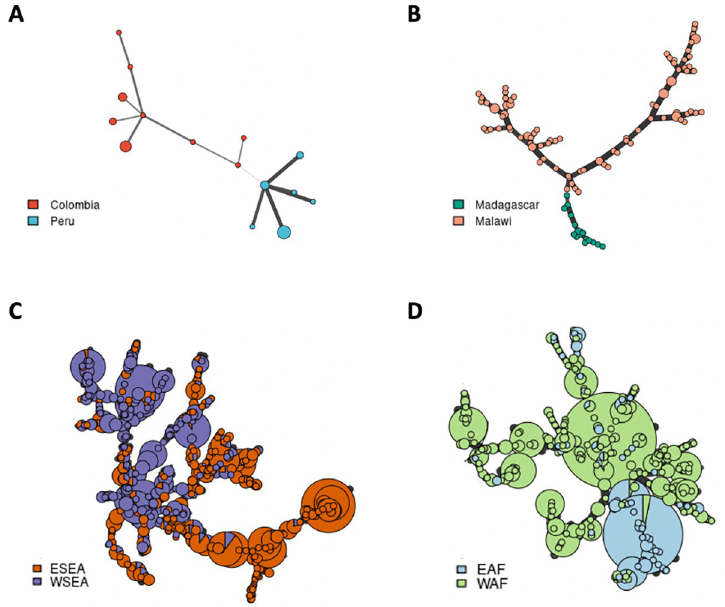
Fig 6. Minimum spanning network among two groups of P . falciparum isolates. Minimum spanning network using Bruvo’s distances based on the ten most informative STR markers. (A) Colombia and Peru from the SAM population. (B) Madagascar and Malawi from the EAF population. (C) ESEA and WSEA populations. (D) EAF and WAF populations. Colors correspond to the country or population. Node sizes correspond to the number of samples. Edge lengths are